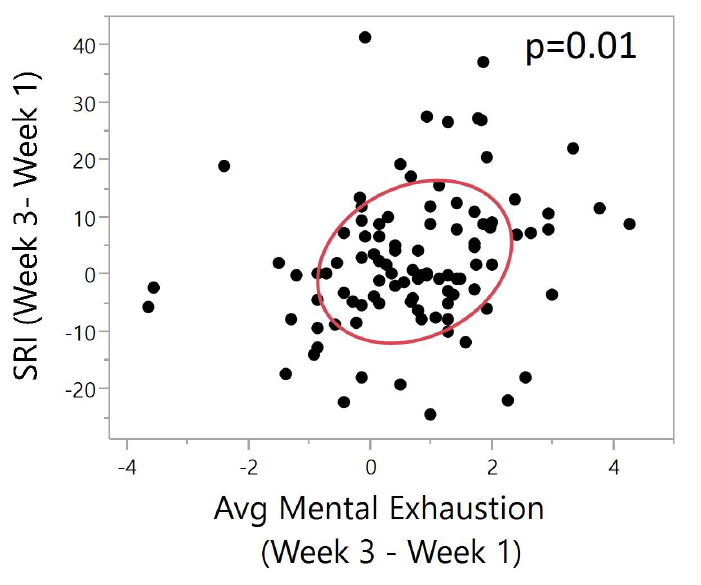
Figure 6. Bivariate plot of SRI (Week 3–Week 1) vs. mental exhaustion (Week 3–Week 1). The red ellipse shows a graphical indicator of the correlation between two di ff erences. The red ellipsoid collapses diagonally as the correlation between them approaches either 1 or − 1. The ellipsoid is more of a circle and less of a diagonal if the two variables are less correlated. The ellipse is encircling 50% of the points on the plot. Significant positive correlation between SRI di ff erence and mental exhaustion di ff erence (Pearson, N = 99, ρ = 0.24, p = 0.01). A higher SRI di ff erence indicates improved sleep regularity between week 3 and week 1. A higher mental exhaustion di ff erence indicates decreased exhaustion between week 3 and week 1. Significant correlation shows that with increased sleep regularity, there is a lower average mental exhaustion between the two time